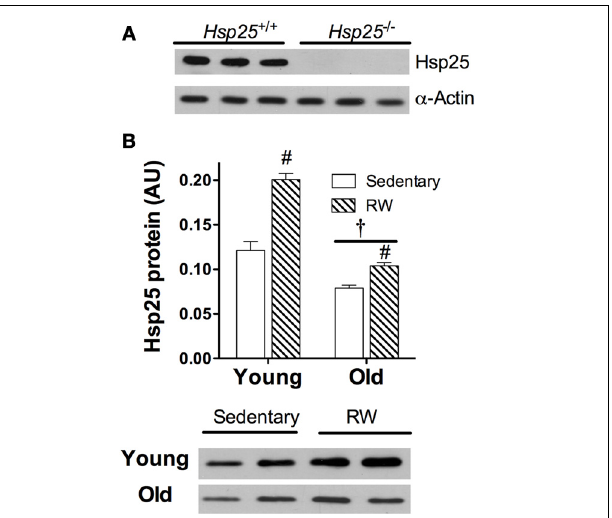
FIGURE 5 | (A) Gastrocnemius muscle HSP25 and actin protein levels in Hsp 25 + / + and Hsp 25 − / − mice verifying the absence of HSP25. (B) HSP25 protein levels in young and old Hsp 25 + / + mice under sedentary conditions or following 14 days of running wheel activity. # Significantly different from sedentary ( P < 0 . 0001), † significant main effect of age ( P < 0 . 0001). Representative western blot showing HSP25 in sedentary and running wheel young and old Hsp 25 + / + mice. Data are presented as means ± SE, n = 8 for all groups.